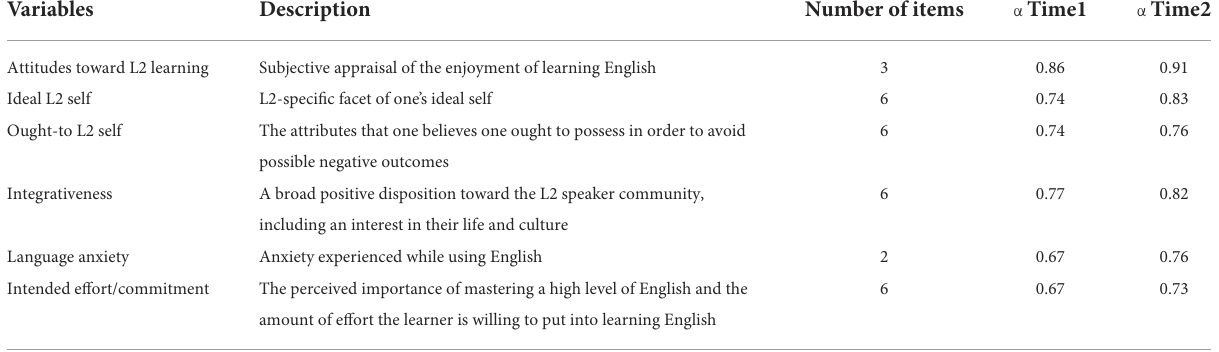
TABLE 1 The attitudinal/motivational variables measured in the current